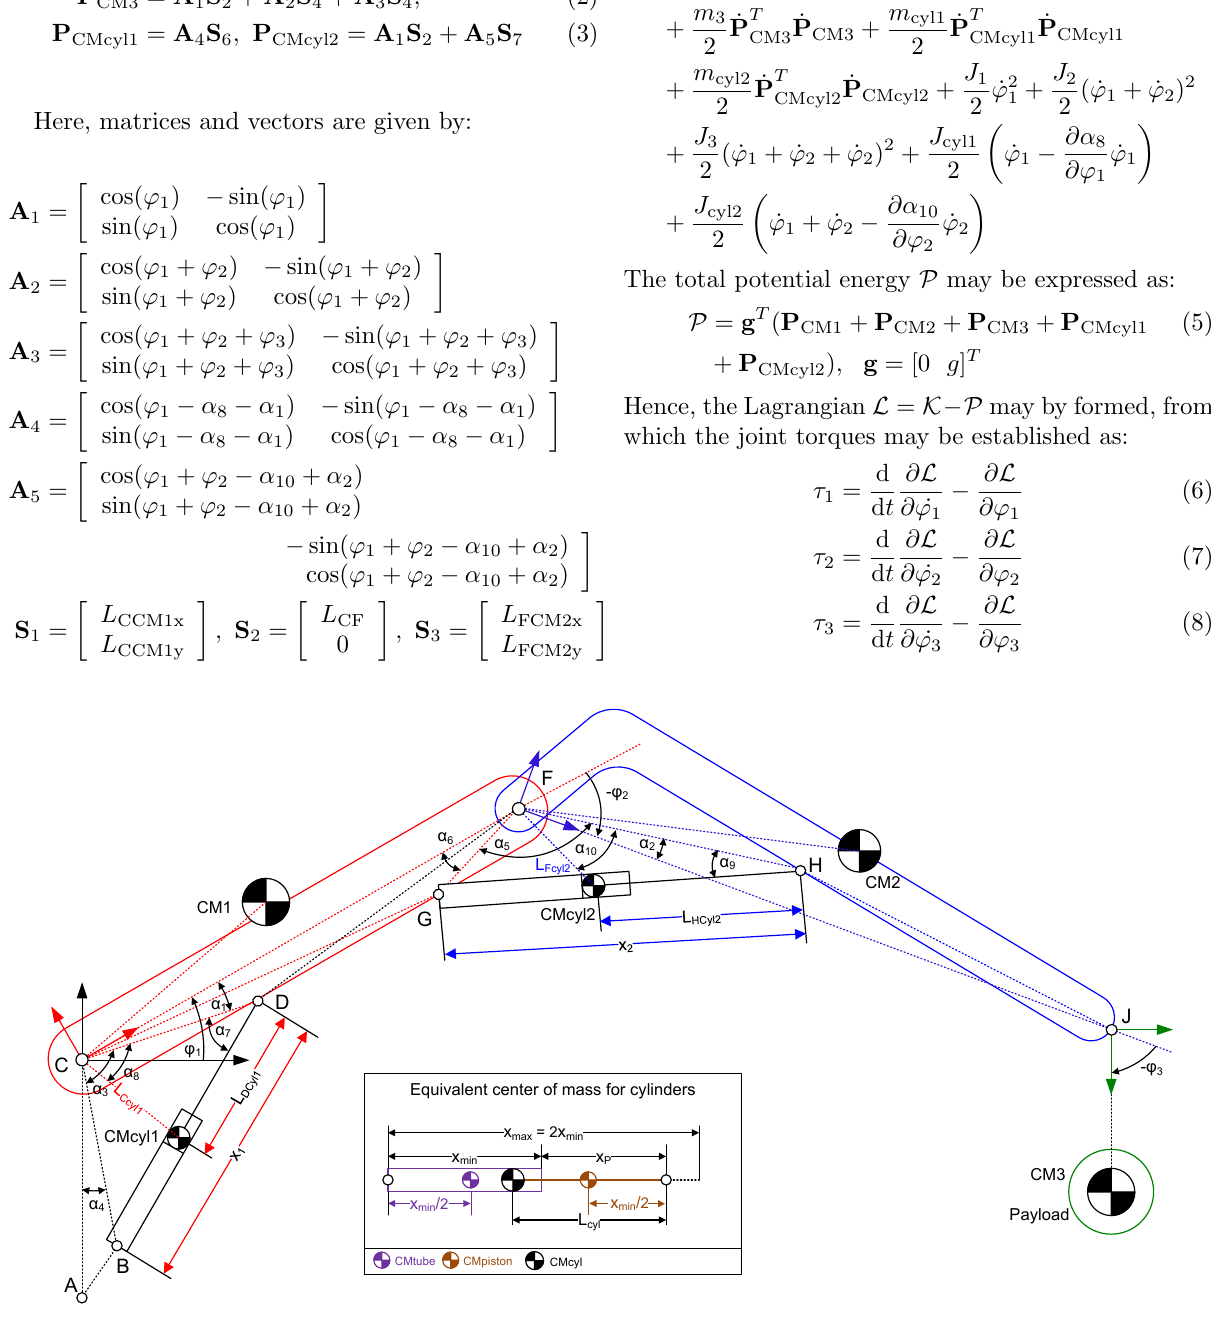
Figure 3: Illustration of a knuckle boom crane with two hydraulic